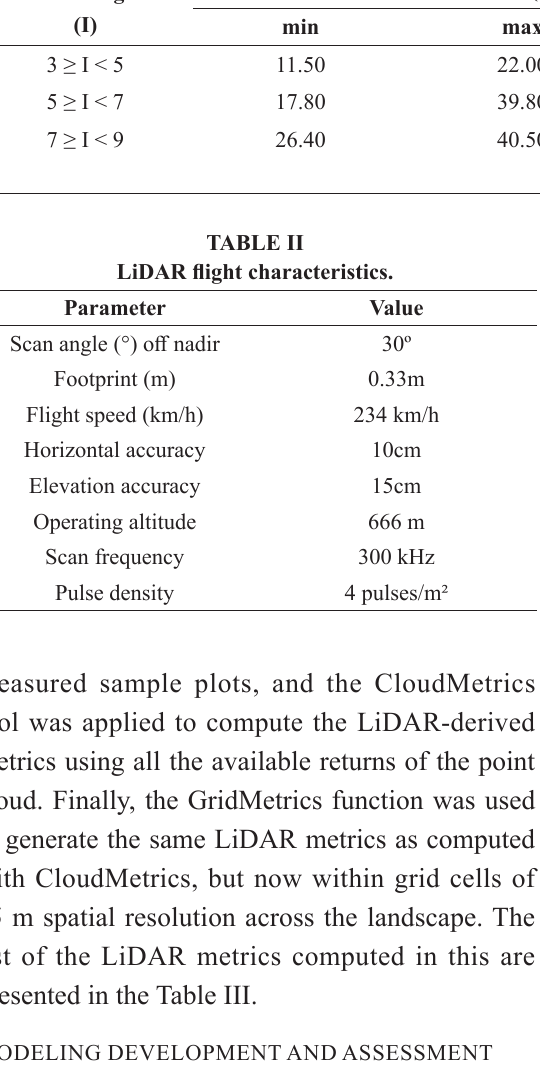
Characteristics of the study plots. Basal Area (BA) values are based on in-situ measured sample plots (n=50). Stand Age